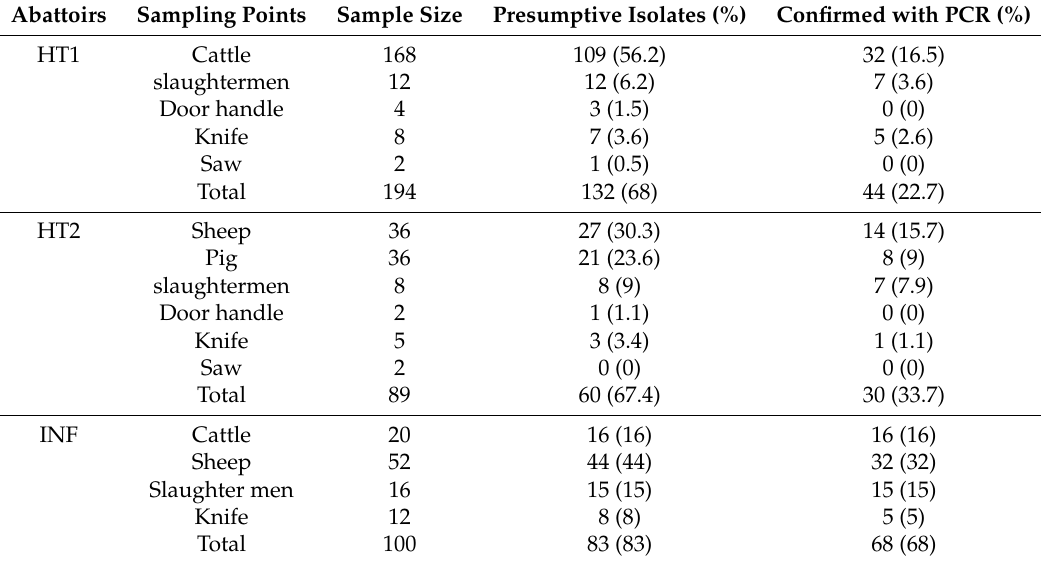
Table 4. Presence of S. aureus isolated from two high throughout abattoirs [HT1 ( n = 194) and HT2 ( n = 89)] and informal meat sector [INMS ( n =